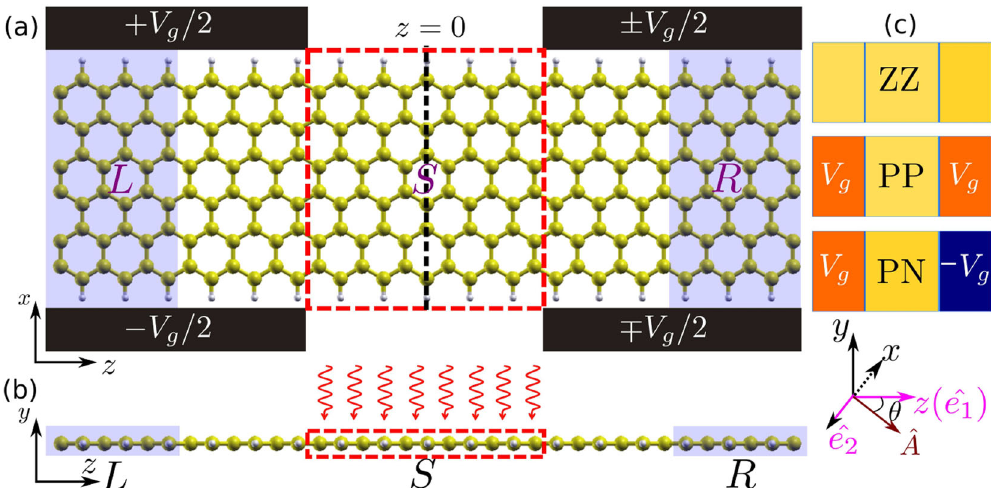
Fig. 1 Spin photogalvanic device model. The a top view and b front view of the proposed spin photogalvanic device model based on 6-ZGNR. e 1 ¼ ^ z and e 2 ¼ (cid:2) ^ x are two polarized vectors that determine the incident direction of the polarized light. The red spiral arrows denote the applied polarized light. A is the electromagnetic vector potential and θ is the polarization angle of the polarized light. The black dashed line denotes the mirror plane. c Three gate con fi gurations: ZZ, PP, and PN. Here, ZZ denotes that there is no gate voltage applied in device. PP (PN) denotes that a positive (positive) gate voltage is applied in the left lead and a positive (negative) gate voltage is applied in the right